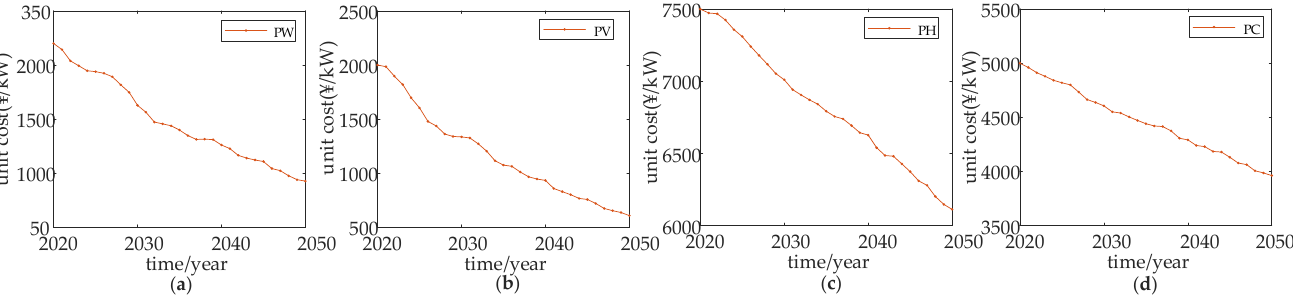
Figure 9. Forecasted investment costs for power generation technologies. ( a ) wind power; ( b ) solar power; ( c ) hydroelectricity; ( d ) thermal power.